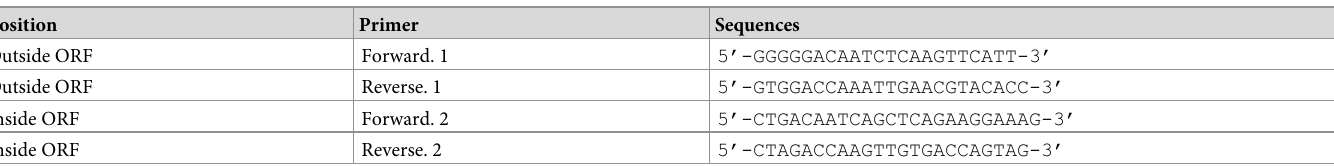
Table 1. PCR primers sequences for TDAT gene.